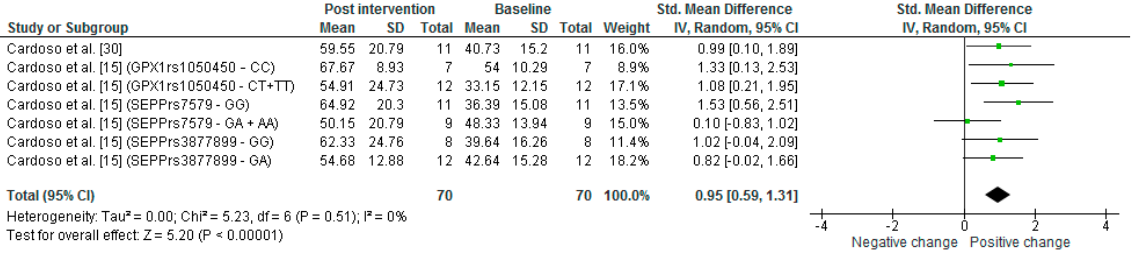
Figure 6. Meta-analysis of GPX activity in erythrocyte observed in Se supplementation group in MCI patients comparing pre and post Se supplementation [15,30].